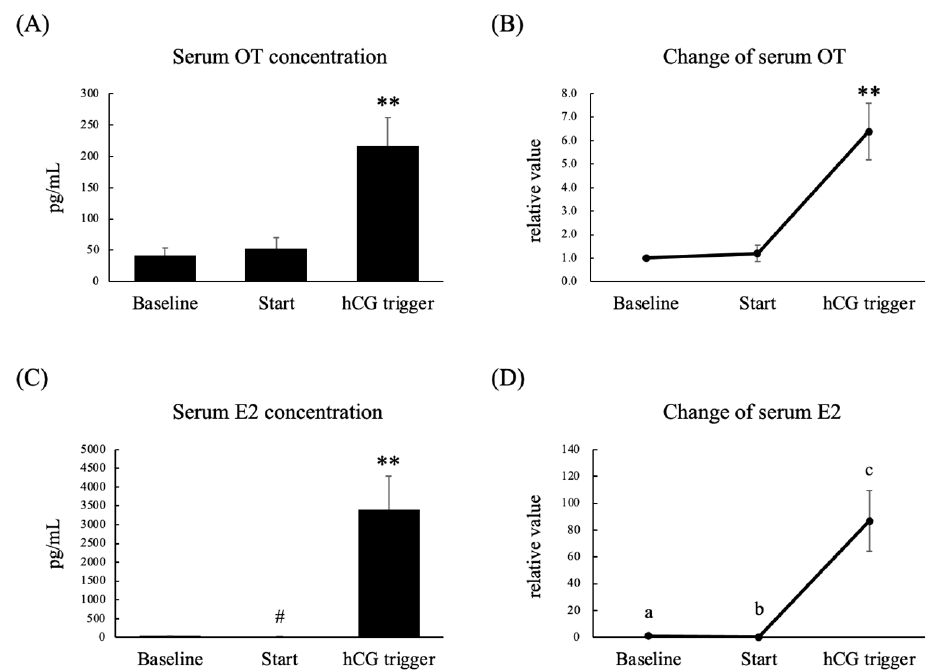
Figure 3. Serum OT concentration ( A ), relative serum OT concentration ( B ), serum E2 concentration ( C ), and relative serum E2 concentration ( D ) on menstrual days 3–5 in the previous cycle (baseline), on the initial day of stimulation (Start), and on the day of the hCG trigger in infertile women who were scheduled for controlled ovarian stimulation. The relative values for each phase were calculated by dividing the measured levels by the levels seen in the follicular phase. Data are expressed as the mean ± standard error. Different letters (a–c) indicate significant differences. n = 7 per group; ** p < 0.01, # p < 0.05 vs. baseline.